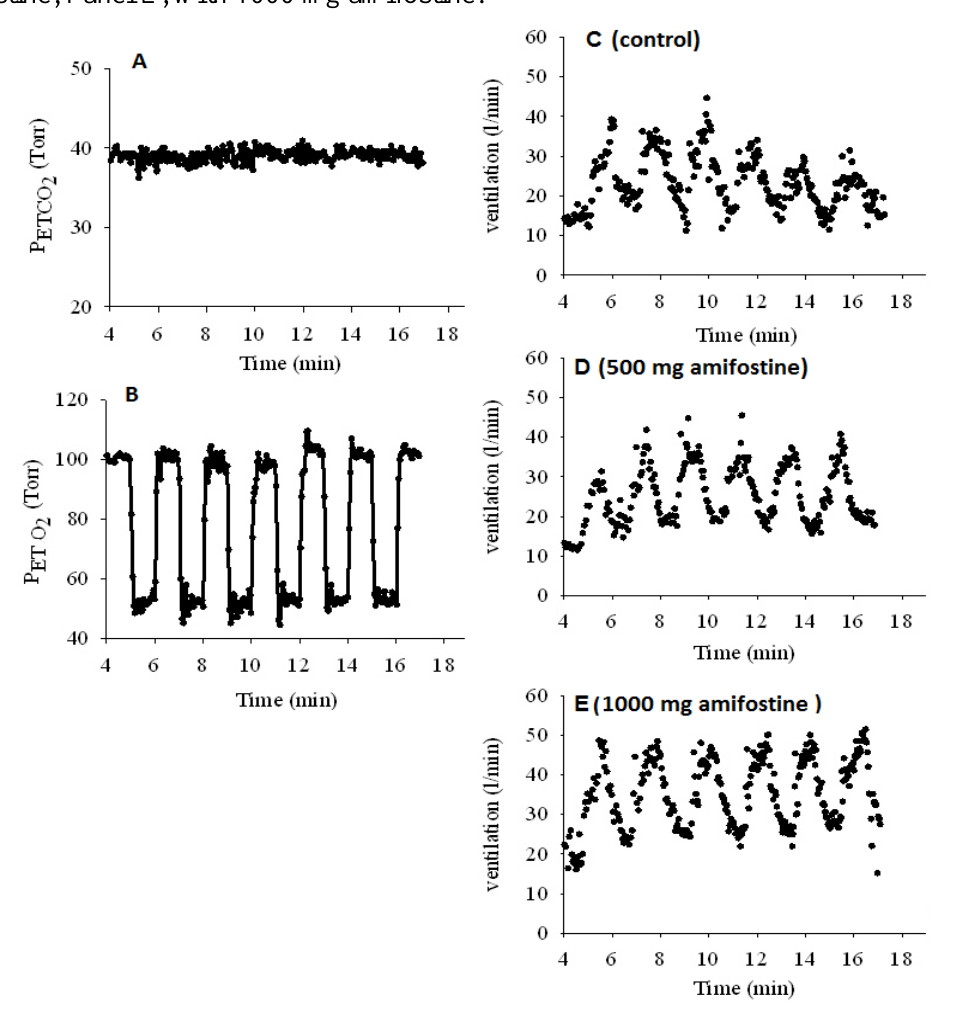
Figure 1. Panels A and B: Gas input protocol for one example subject for the ~20 min period of measurement of hypoxic ventilatory response. Panel A, PET CO2 ; Panel B, PET O2 profile. Panels C–E: Ventilatory responses for one example subject for the ~20 min period of measurement of hypoxic ventilatory response. Panel C, control; Panel D, with 500 mg amifostine; Panel E, with 1000 mg